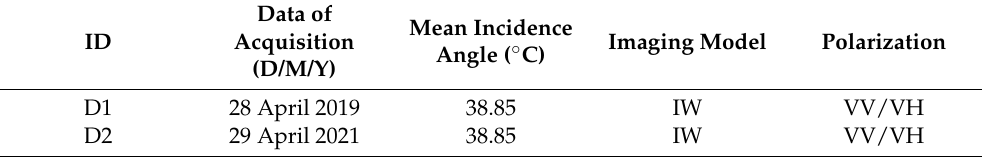
Table 2. S1 images used in this